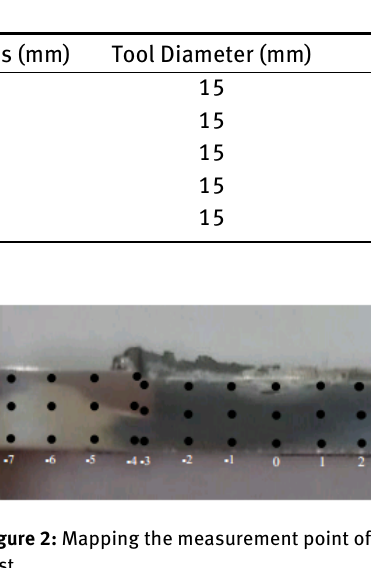
Table 1: Parameters of friction stir processing.